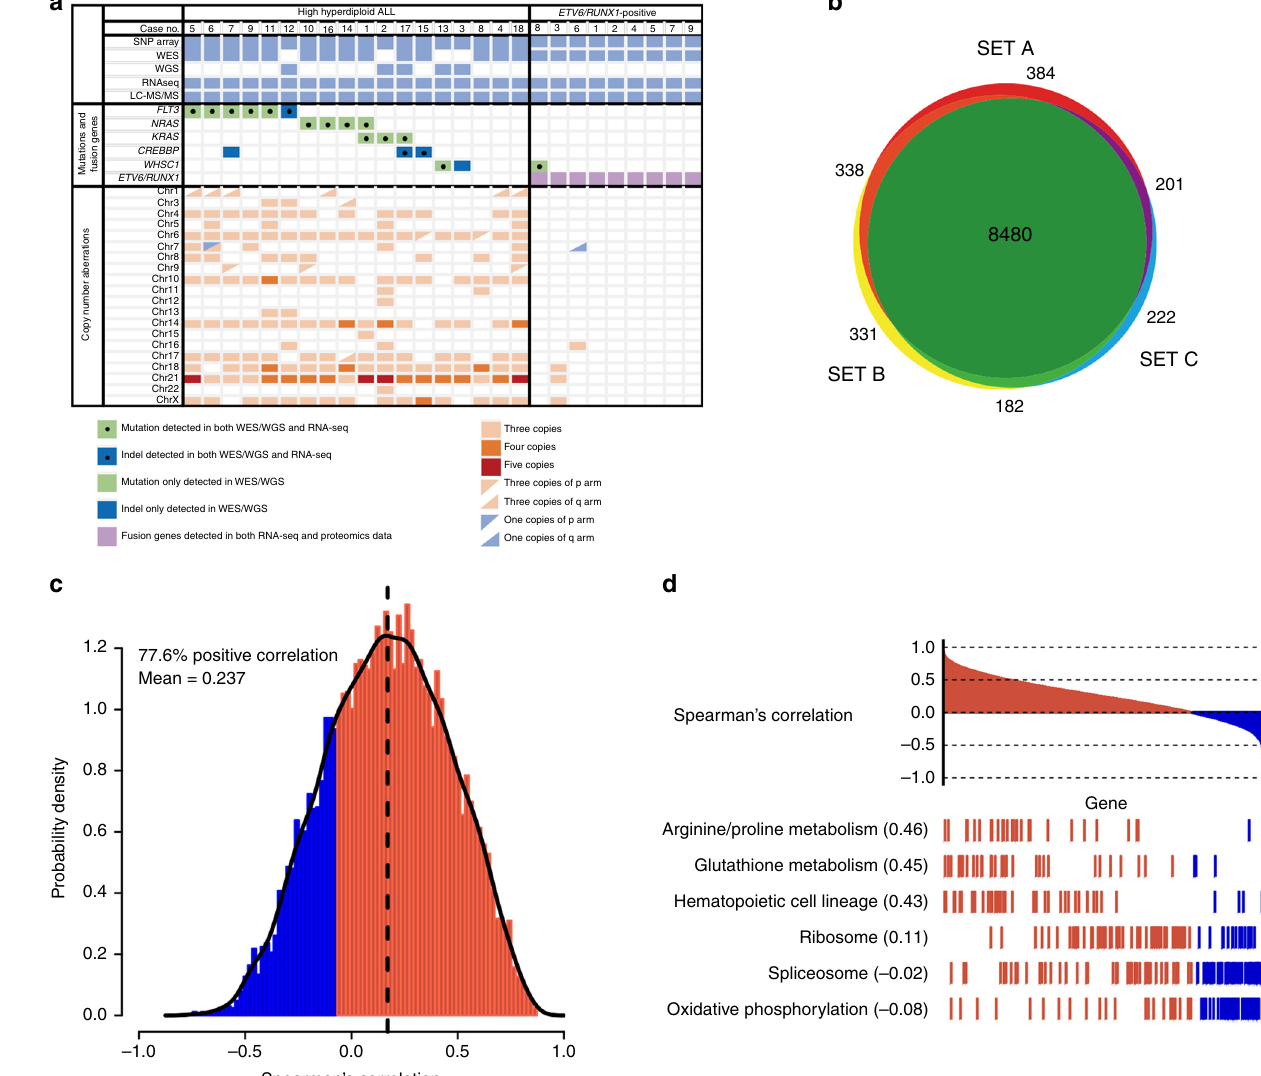
Fig. 1 Proteogenomic study of childhood B-cell precursor acute lymphoblastic leukemia (ALL). a Genomic landscape of 27 childhood ALL included in the proteogenomic analysis. All cases were disomic for chromosomes 2, 19, and 20. b Numbers of proteins overlapping across the 3 TMT-sets. c Spearman ’ s rank order correlation between mRNA and protein abundance. The correlation was positive for 77.6% mRNA-protein pairs in the whole cohort of cases with a mean Spearman ’ s correlation coef fi cient of 0.24. Approximately 23% mRNA-protein pairs showed signi fi cant correlation (multiple-test adjusted P ≤ 0.05). d When investigating different biological processes, mRNA and protein levels displayed the highest correlation for specialized pathways, such as hematopoietic cell lineage and amino acid metabolism, and lowest for house-keeping functions, e.g., ribosomal and spliceosomal